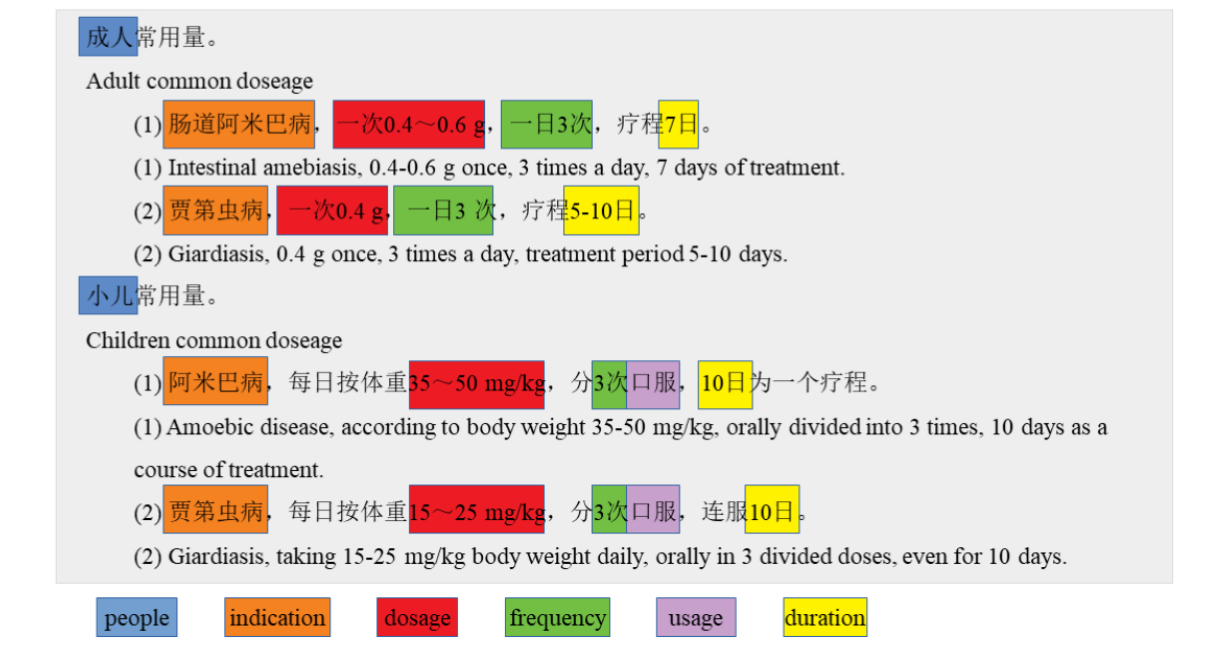
Figure 4. Illustration of the categories and values for properties that need to be extracted from usage section in the instruction of metronidazole